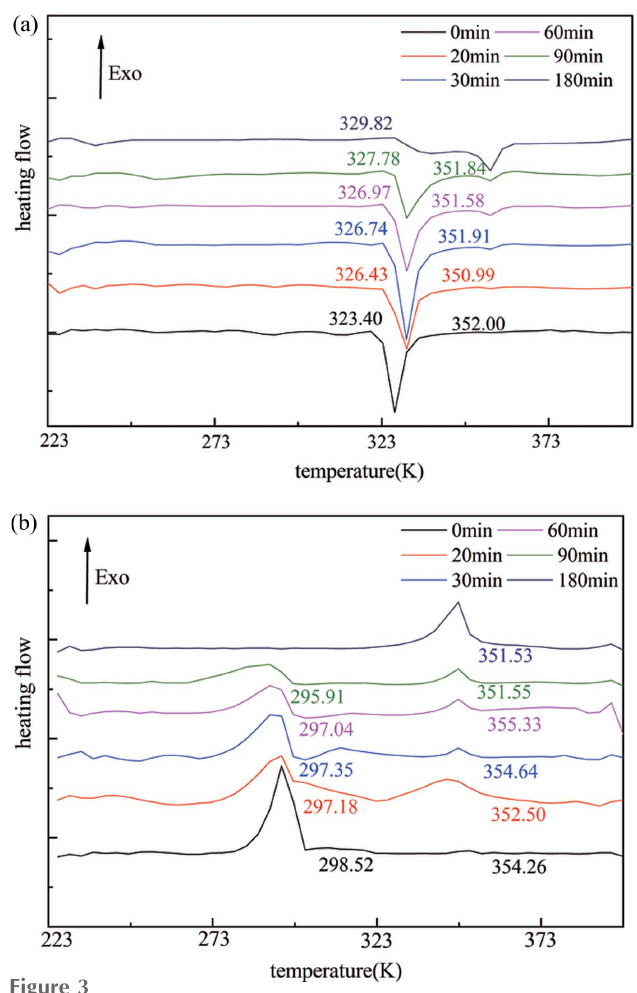
Figure 3 DSC temperature cycle thermograms of dl -methionine (cid:3) polycrystalline powders with different milling times during ( a ) the heating process and ( b ) the cooling